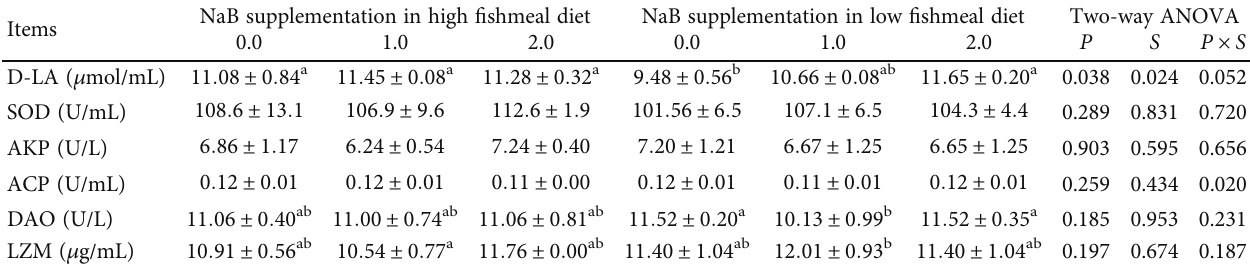
Table 6: E ff ect of dietary sodium butyrate on serum biochemical indices of rainbow trout. NaB supplementation in high fi shmeal diet NaB supplementation in low fi shmeal diet Items